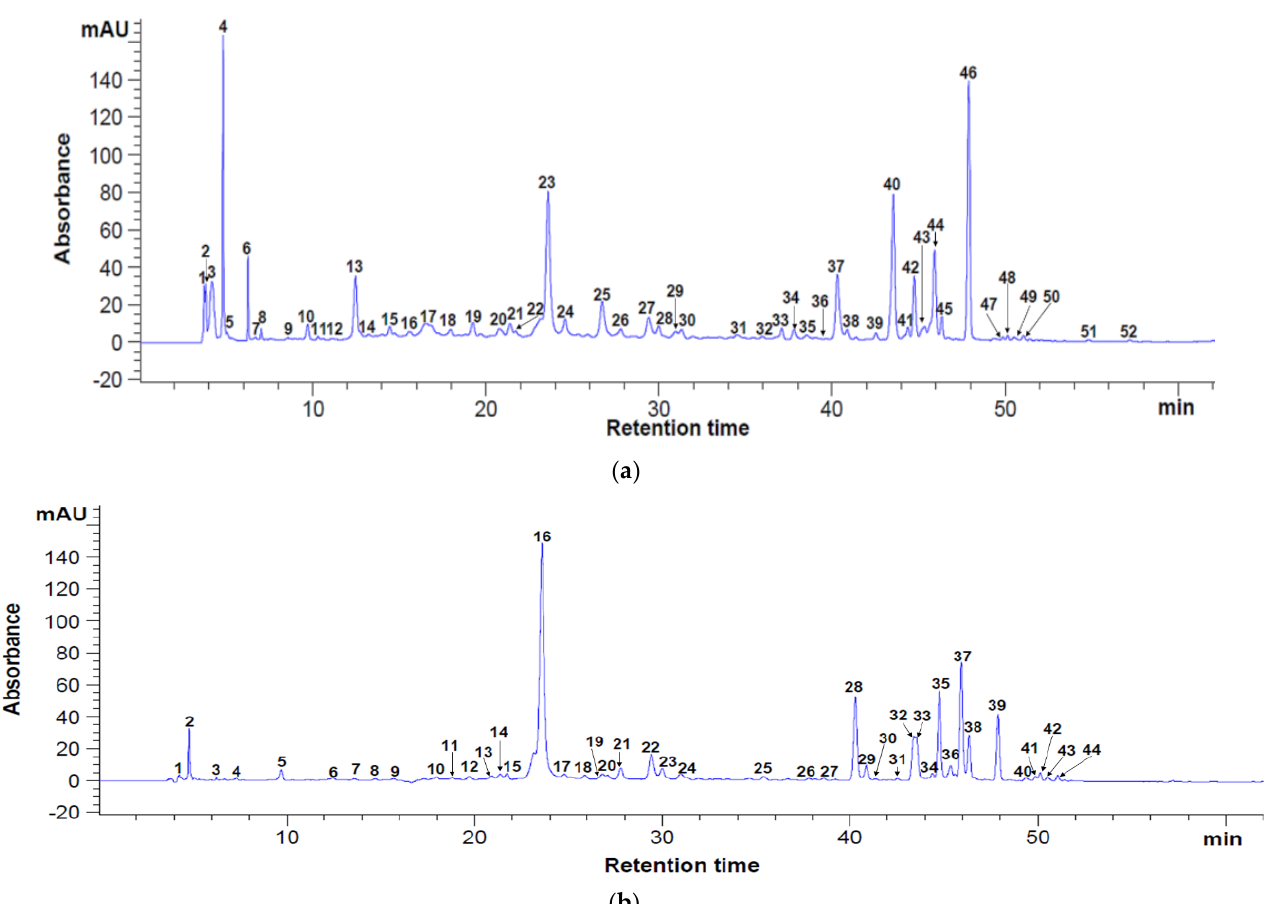
Figure 1. HPLC analysis for free polyphenolic compounds in freeze-dried apple pomace extract at 280 nm ( a ) and 320 nm ( b ). Peaks’ identification: ( a ): 4 — theaflavin, 5 — cafestol, 16 — protocatechuic